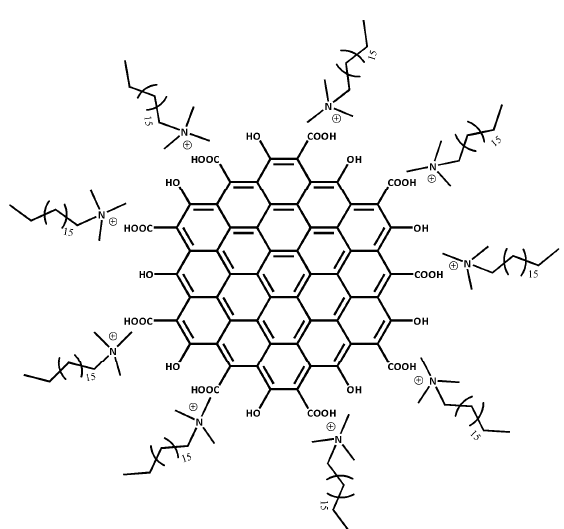
Figure 1. Possible structure of cetyltrimethylammonium bromide/hydroxylated graphene quantum dots (CTAB/HGQDs) composite.